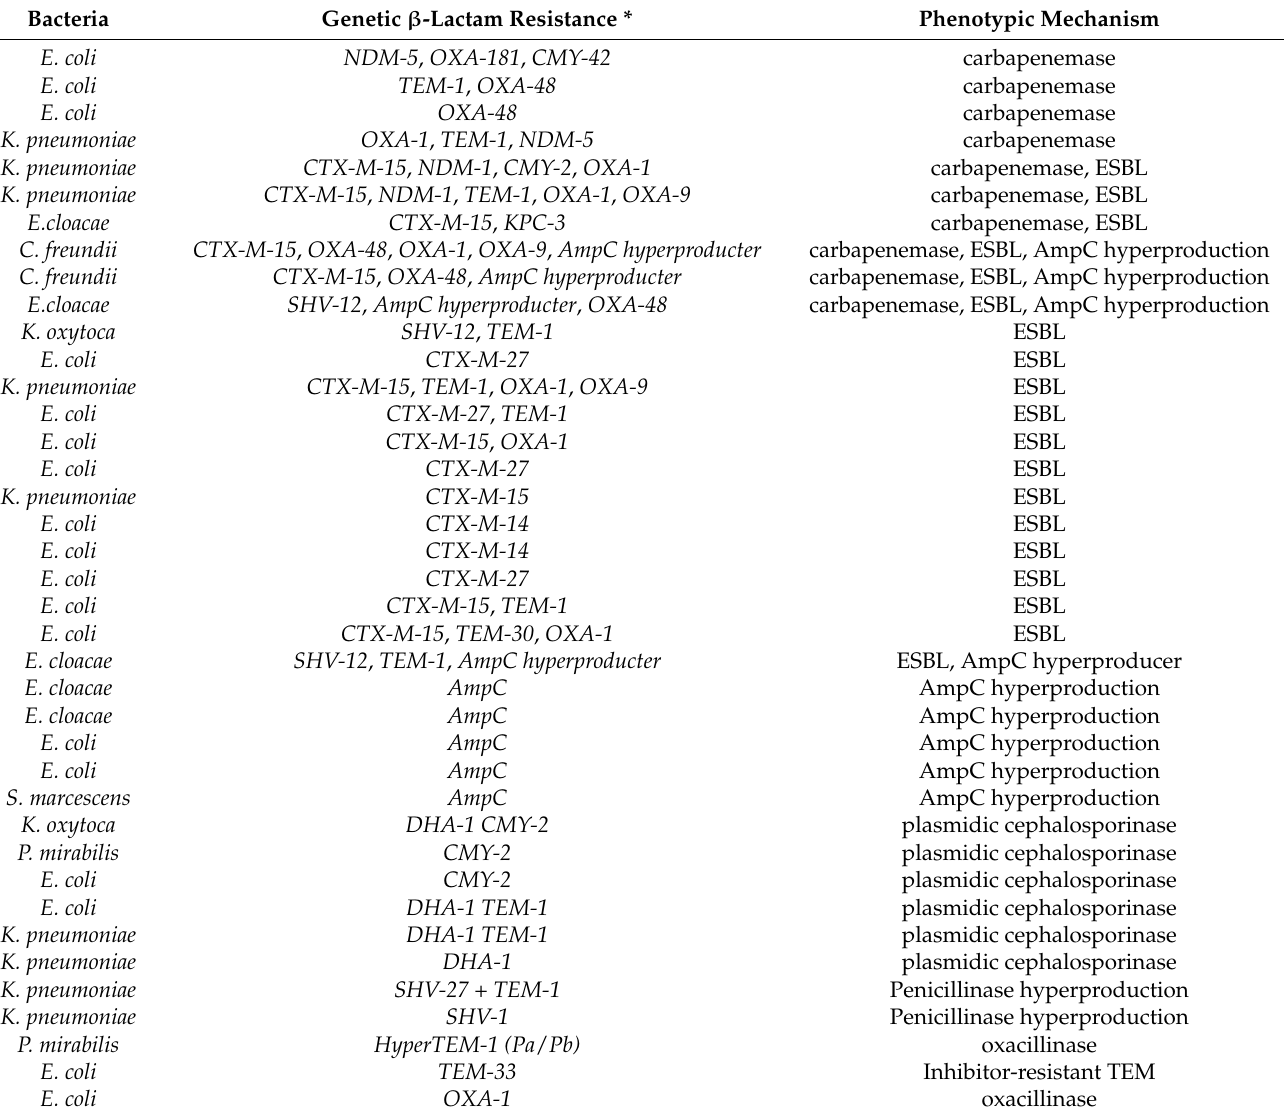
Table 1. β -lactam resistance mechanisms of 39 selected Enterobacterales isolates evaluated with MHR-SIR and MH